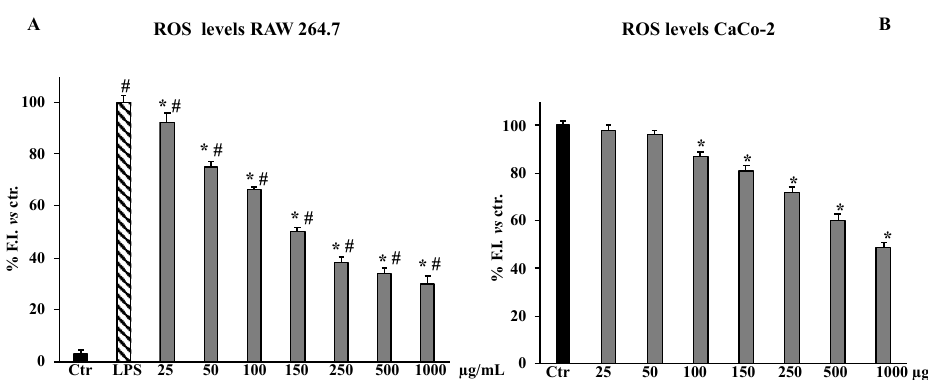
Figure 4. ROS levels in RAW 264.7 ( A ) and CaCo-2 ( B ) untreated cells (Ctr), LPS-treated for 2 h, and pre-treated with the total extract (25–1000 µ g/mL) for 24 h. Values are the mean ± S.D. of five experiments in triplicate. Confidence intervals calculated by two-way ANOVA and Tukey post-hoc test: # Significant vs. untreated control cells: p < 0.001; * Significant vs. LPS-treated cells: p < 0.001.